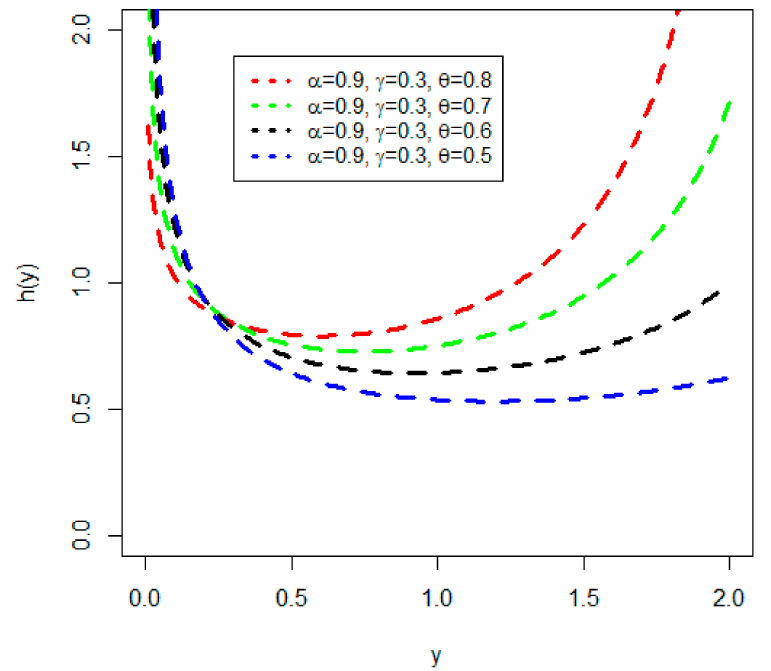
Figure 3. Plots of different bathtub shapes of HF h ( y ; α , ∆ ) of the proposed NMEPA-Wei